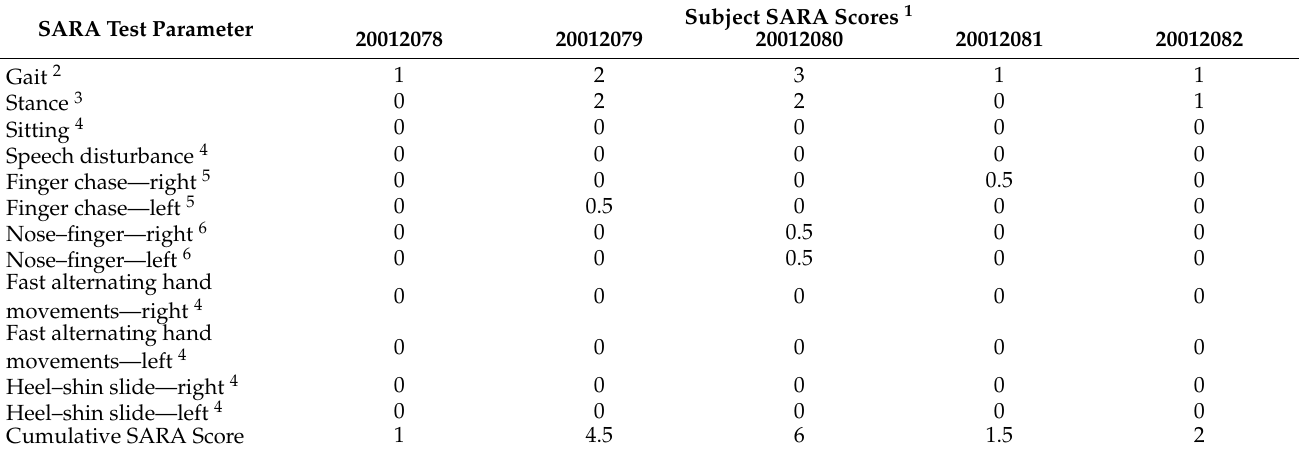
Table 5. Neurotoxicity as assessed by the Scale for the Assessment and Rating the of Ataxia (SARA) method